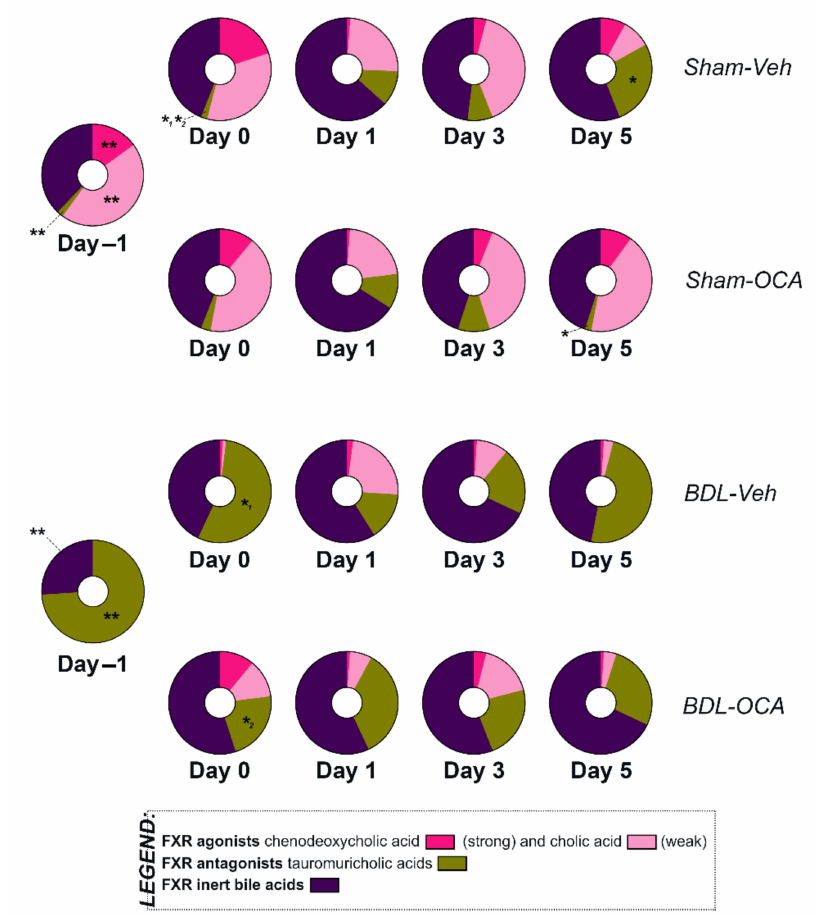
Figure 7. Serum fractional contribution of FXR agonists chenodeoxycholic acid and cholic acid, FXR antagonists tauromuricholic acids, and FXR-inert BAs to the total serum BA pool 1 day before PHx ( t = − 1 day), on the day of PHx ( t = 0 days), and 1, 3, and 5 days after PHx. Significance in fractional contribution per BA between groups on the same time point was assessed using a Mann–Whitney U test (for t = − 1 day) or a Kruskal–Wallis test with Dunn’s multiple comparisons test (for t = 0, 1, 3, and 5 days). * indicates p ≤ 0.05; ** indicates p ≤ 0.01. For intergroup analysis: * 1 , Sham-Veh vs BDL-Veh; * 2 , Sham-Veh vs BDL-OCA. BAs, bile acids; Veh, Vehicle; BDL, bile duct ligation; OCA, obeticholic